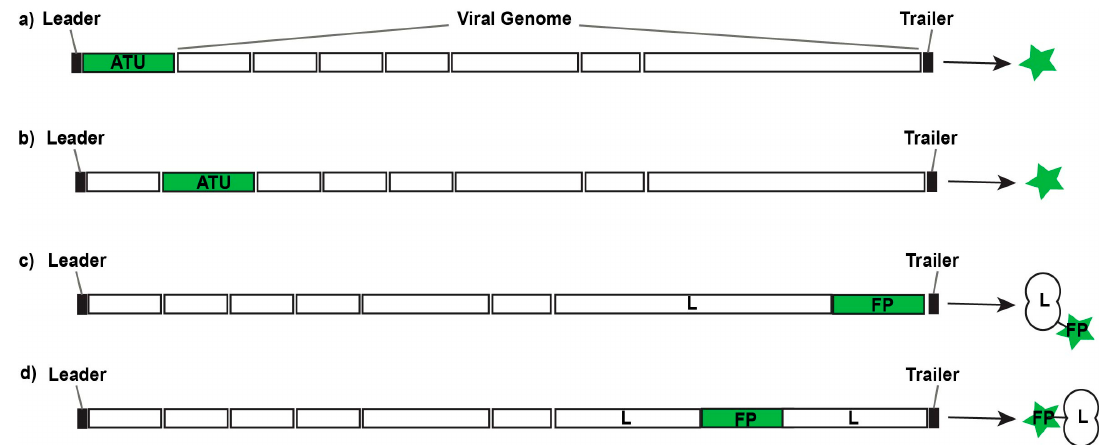
Figure 2. Design strategies for replication-competent fluorescent or bioluminescent reporter viruses. Additional transcription units (ATUs) can be inserted 3’ of the first gene in the viral genome ( a ) or 5’ of the final gene in the viral genome; between viral genes ( b ); or their sequences can be fused with viral genes to generate fusion proteins (FPs) either at the N-terminus or C-terminus ( c ) of a viral gene; or at inert hinge regions within a viral protein ( d ).